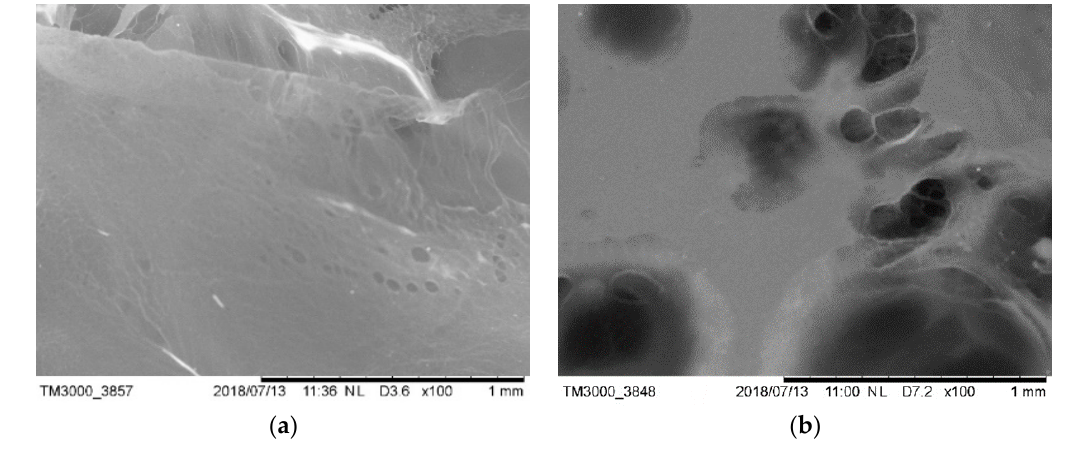
Figure 10. SEM image of HPMC in water; ( a ) HW1; ( b ) HW2.